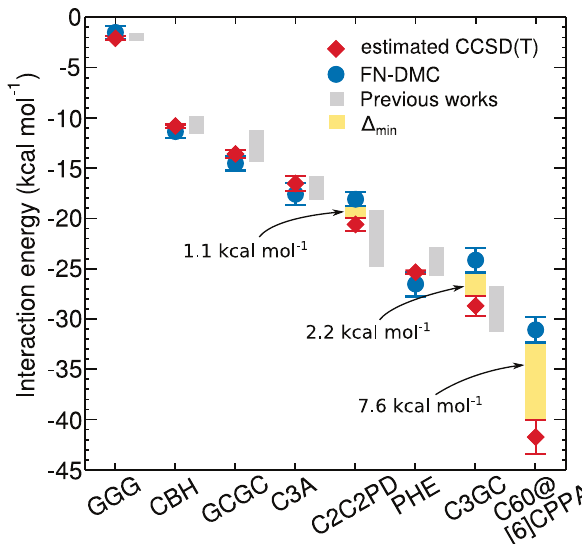
Fig. 3 CCSD(T) and FN-DMC interaction energies for supramolecular complexes. The L7 data set 28 and the C 60 @[6]CPPA buckyball-ring complex are arranged in terms of increasing interaction strength. Gray bars mark the range of interaction energies reported in the literature using alternative wavefunction-based methods (e.g., QCISD(T) 28 , and various local CCSD(T) approaches 49,51,52,67 – 70 ). The yellow bars indicate the delta value ( Δ min ) which is the minimum difference between best converged CCSD(T) and FN-DMC, given by the estimated and stochastic error bars (with 95% con fi dence interval),